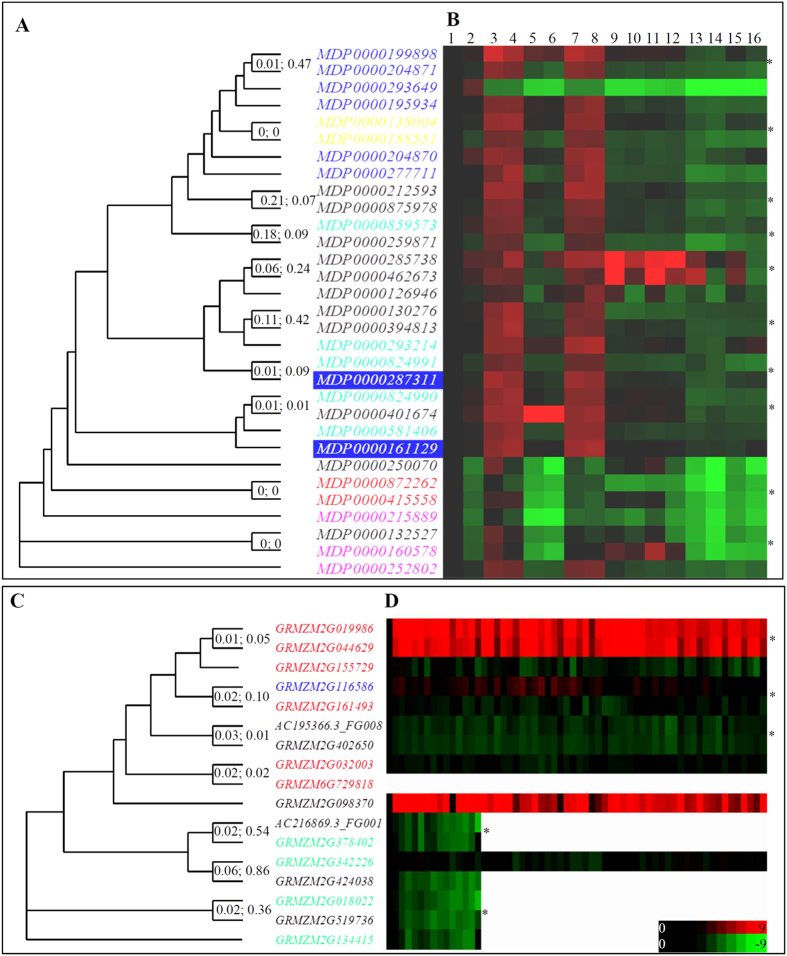
Expression patterns and divergence of both apple SuSy and maize UDPGP gene families among various tissues.(A) The phylogenetic tree of the SuSy family in apple. The apple family was expanded only by tandem duplication. Locus names with black fonts indicate that these genes were not duplicated. A total of 6 tandem clusters were identified and they were labelled with blue, brown, green, white with blue background, red and pink colors. (B) The expression profiling of this gene family among 16 tissues. Expression data were downloaded from the NCBI datasets (Methods) with accession number GSE42873. These issues were listed as below: 1, Flower_M67; 2, Fruit_M74_100 daa; 3, Flower_M74; 4, Fruit_M20_100 daa; 5, Leaf_M14; 6, Fruit_M20_harvest; 7, leaf_M49; 8, Fruit_M74_harvest; 9, Root_GD; 10, Stem_X8877; 11, Root_X8877; 12, Stem_GD; 13, Seedling_GD; 14, Seed_X4442 × X2596; 15, Seedling_X4102; and 16, Seed_X3069 × X922. (C) The phylogenetic tree of the UDPGP family in maize. Locus names with red and green fonts indicate that they were from segmental duplication and TE-mediated expansion, respectively. The locus name with blue fonts indicates that the gene was expanded by TE but was located in a segmentally duplicated block. (D) The expression analysis of two datasets, which were downloaded from the NCBI datasets with accession numbers GSE27004 and SRA012297. These two datasets consisted of 60 and 15 tissues, respectively and their names were listed in their databases. In (A,B) both Ka values and Ka/Ks ratios for these nodes between closely related genes were calculated and were shown in the left and right of semicolon of the node. Normalized expression values were calculated by Agilent GeneSpring GX 11.5 software and were used for heat map analyses as shown in the right panel. Red, black, and green colors indicated the normalized expression values with >0, = 0, and < 0, respectively, in the matrix. The stars “*” indicated the statistical difference in their expression level between these two genes.